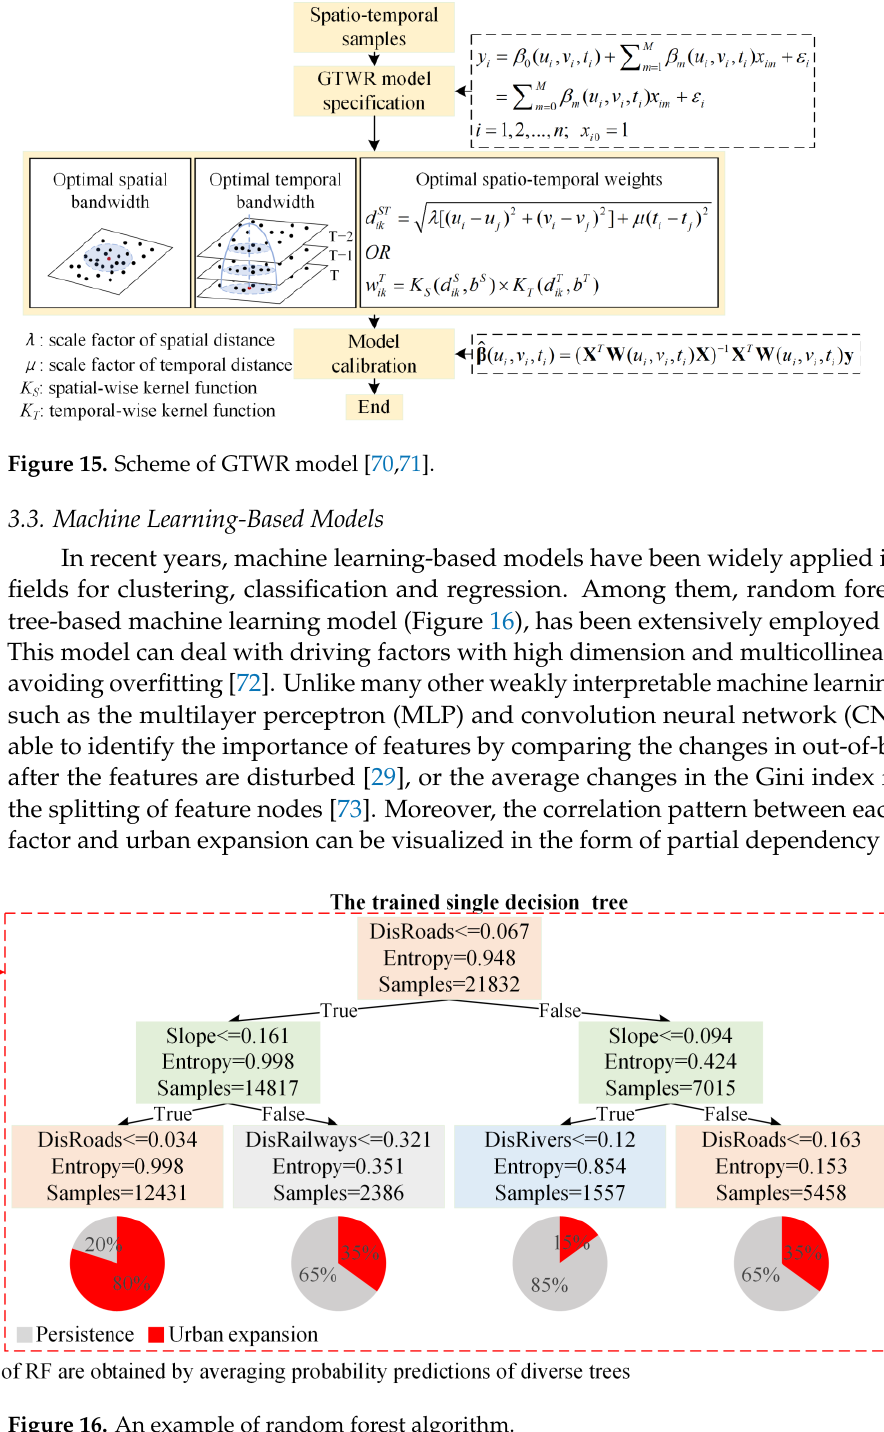
Figure 16. An example of random forest algorithm.